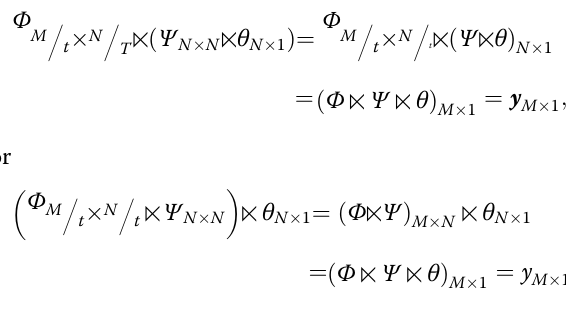
When we assume t = 2, then the dimensions of Φ ( t ) are ( M /2) × ( N /2), and when we assume t = 4, the di- mensions are ( M /4) × ( N /4), etc.. Thus, the storage space of Φ ( t ) is reduced quadratically. For example, to process a 1024 × 1024 image, when the sampling rate is 50% and the data is with double precision floating-point, there are 512 K measurements. A Gaussian